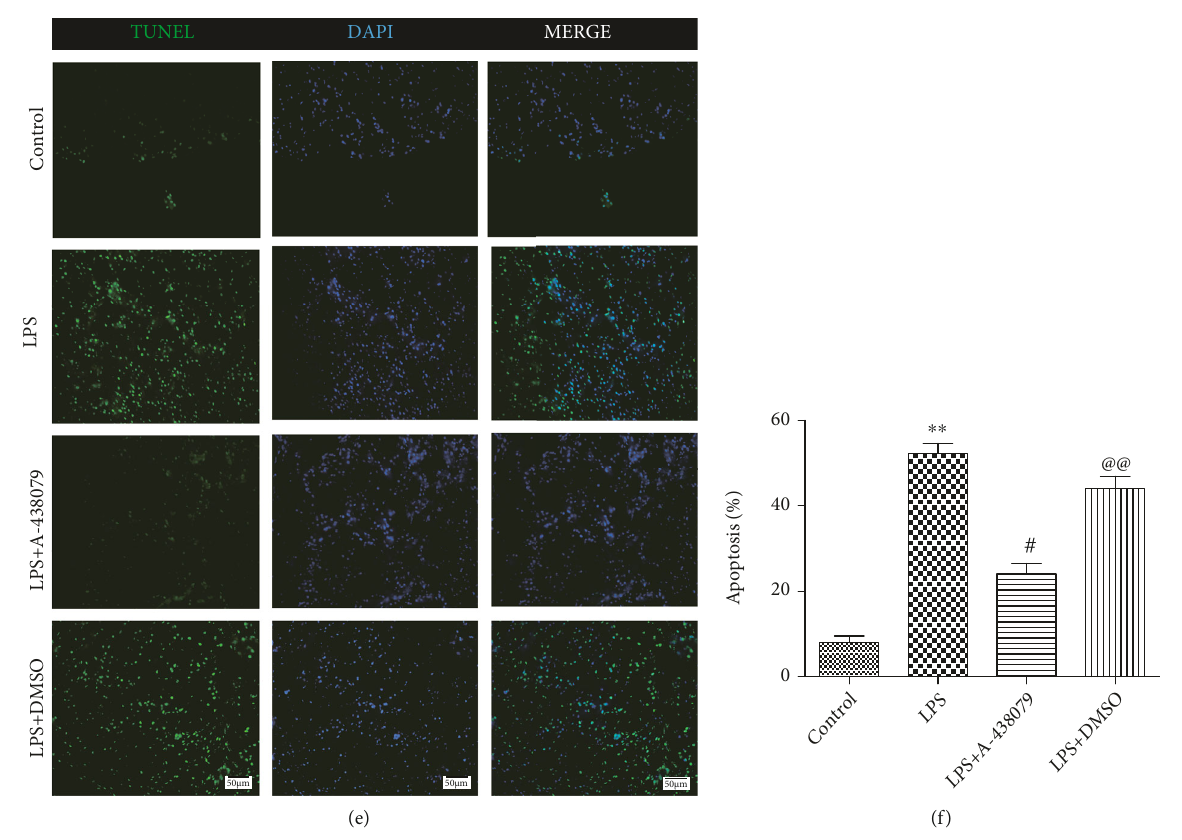
Figure 5: A-438079 inhibited Cleaved caspase-9 and Cleaved caspase-3 expression upregulation induced by LPS stimulation and LPS- induced apoptosis of brain cells in mice. (a) – (d) LPS-induced the increasing of Cleaved caspase-9 and Cleaved caspase-3 expression was inhibited by A-438079. All data are expressed as mean ± SD . ∗∗ P < 0 : 01 compared with control, # P < 0 : 05 compared with LPS, @@ P < 0 : 01 compared with LPS + A − 438079 . (e) and (f) TUNEL fl uorescence staining shows apoptosis of cells in the brain of mice. Scale bars = 50 μ m . All data are expressed as mean ± SD . ∗∗ P < 0 : 01 compared with control, # P < 0 : 05 compared with LPS,